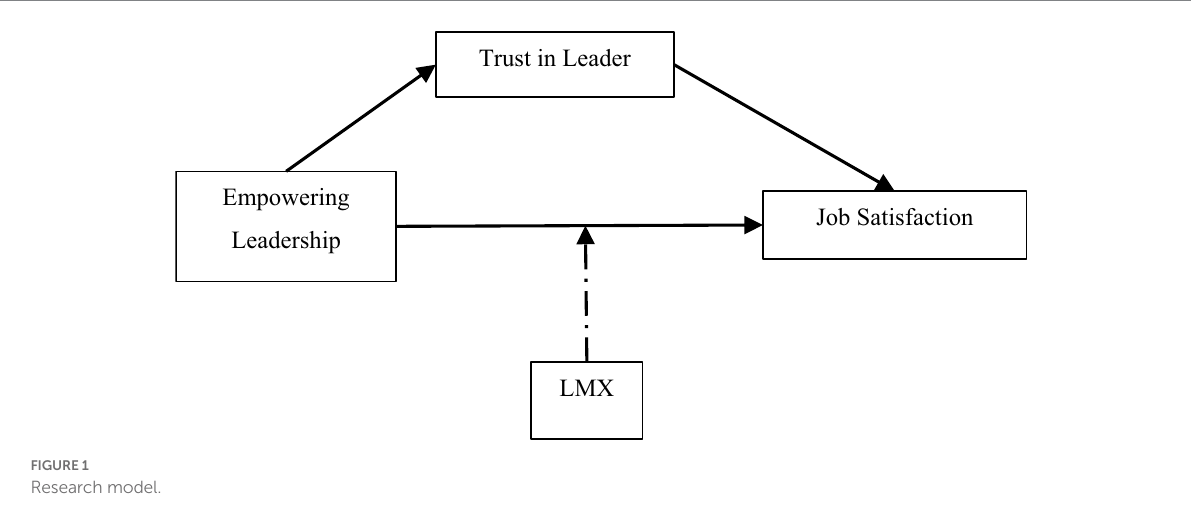
FIGURE 1 Research